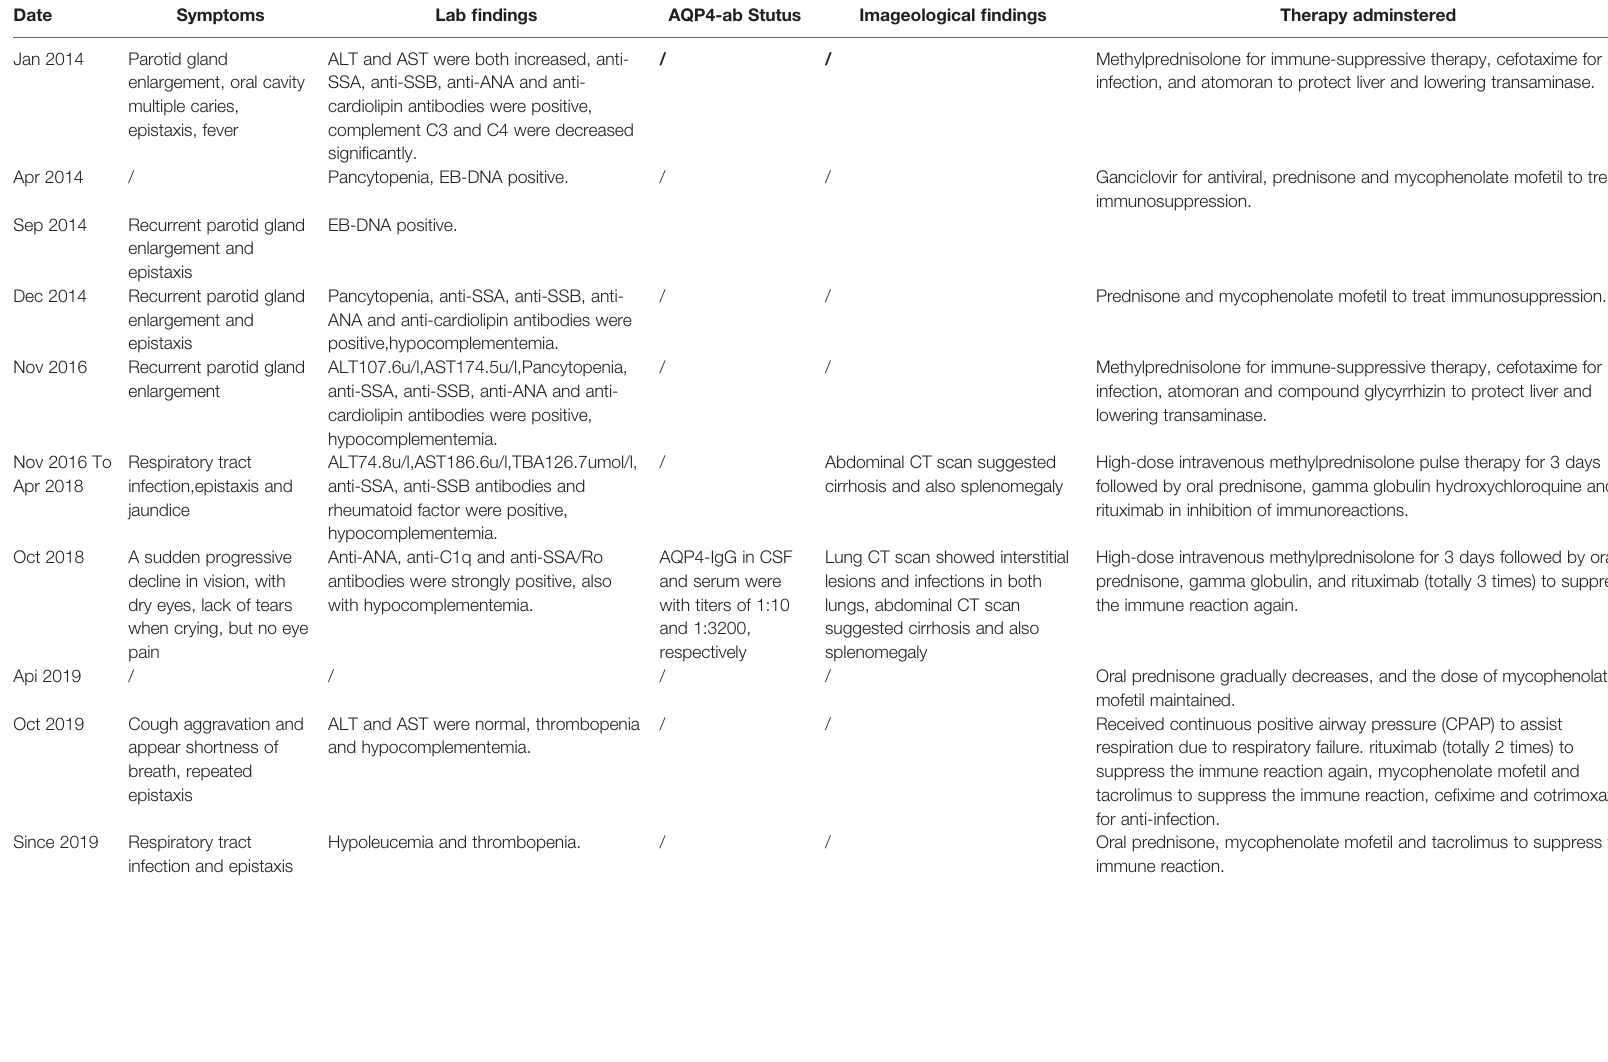
TABLE 1 | Timeline of